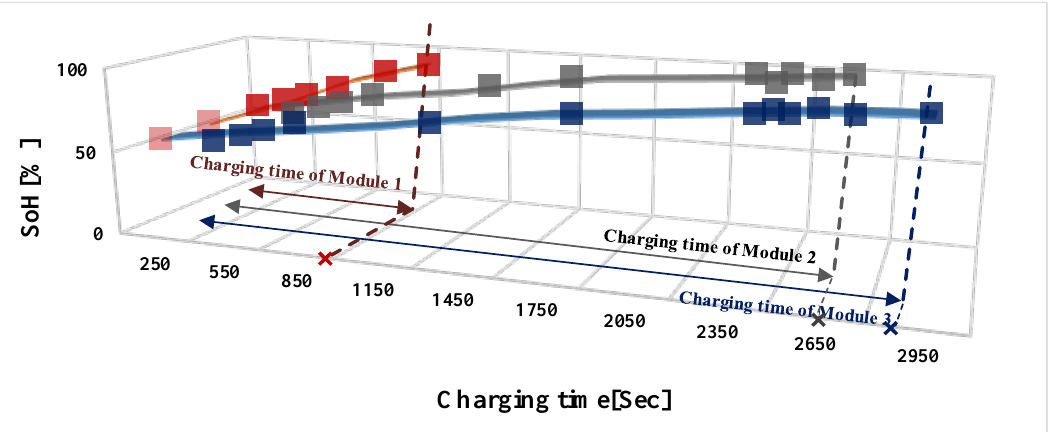
Figure 17. Current flow in charge control according to SoC state.